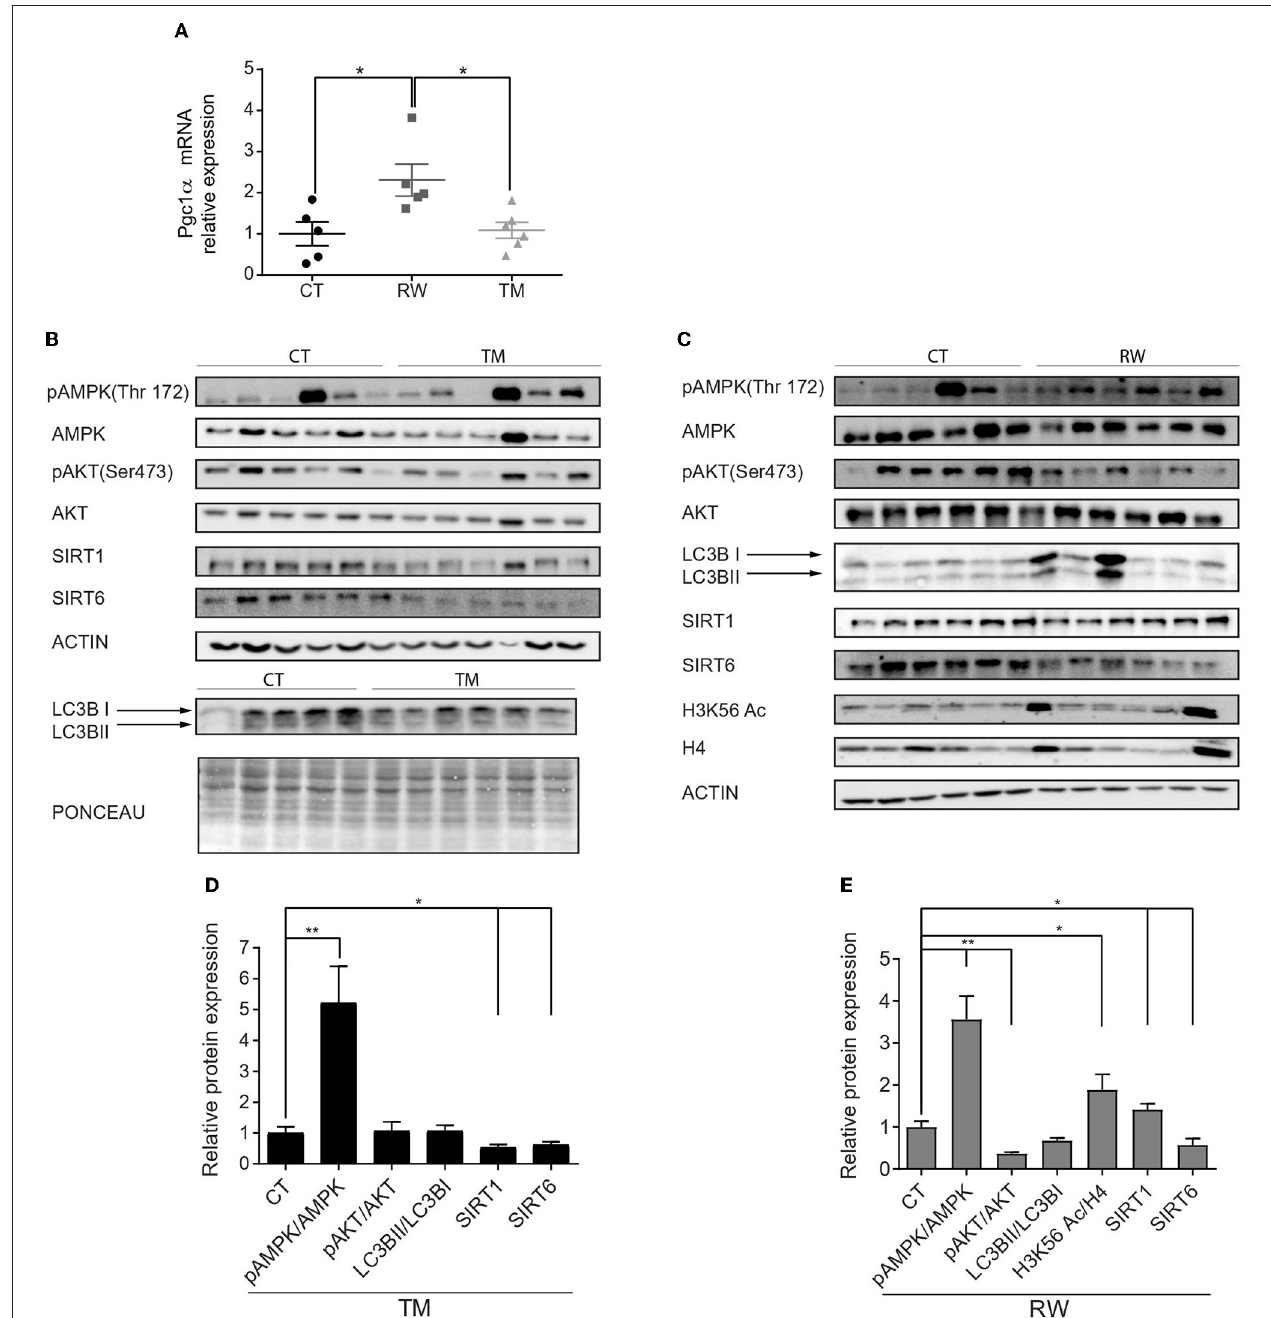
FIGURE 2 | Activation of skeletal muscle AMPK signaling pathway is stronger under voluntary exercise. (A) Relative gene expression levels of Pgc1 α . (B,C) Western blot analyses of pAMPK, AMPK, pAKT, AKT, SIRT1, SIRT6, H3K56Ac, and LC3B. (D,E) Densities of the bands were normalized to actin or Ponceau staining which served as an internal control in the gastrocnemius muscle of young (4-6 months) WT male mice. Ratios of phosphorylated AMPK to unphosphorylated AMPK, phosphorylated AKT to unphosphorylated AKT, LC3B II normalized to LC3B I, and SIRT1 and SIRT6 protein expression normalized to actin of each blot. H3K56Ac is normalized to H4. The values shown are mean ± s.e.m., * p < 0.05; ** p < 0.01 (ordinary one-way ANOVA for (A) , two-tailed t -test for (D,E) ; n = 5, 6 for CT, TM (black), and RW (gray).